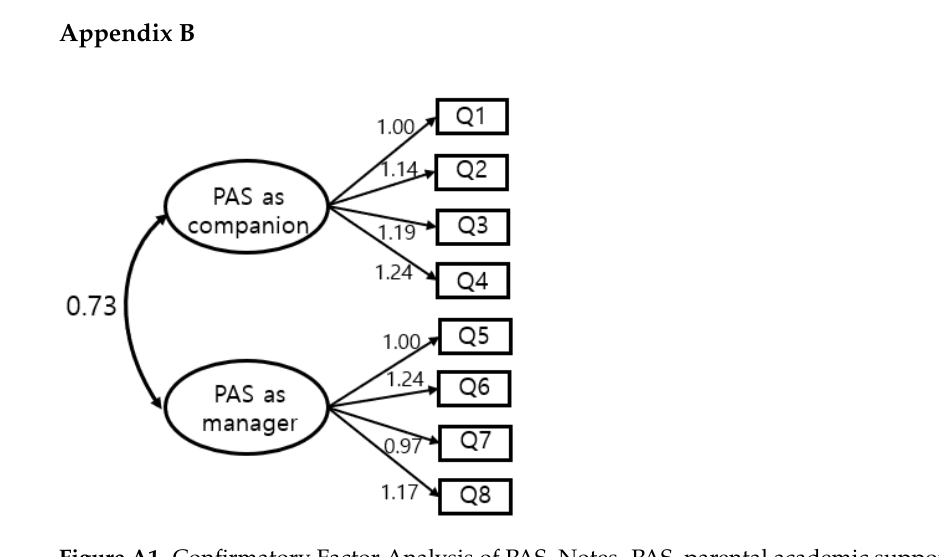
Figure A1. Confirmatory Factor Analysis of PAS. Notes. PAS, parental academic support; Q1–Q8,